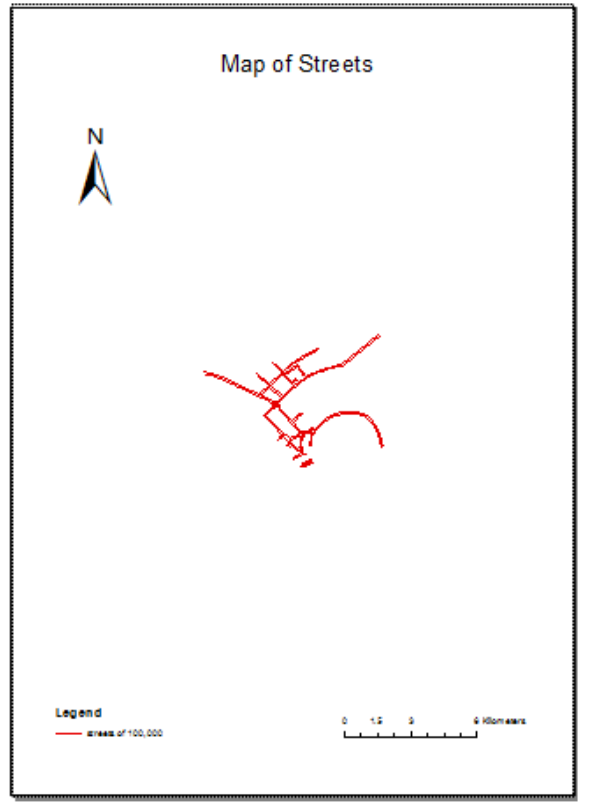
Fig.12: Illustrated the network of roads map from map at scale